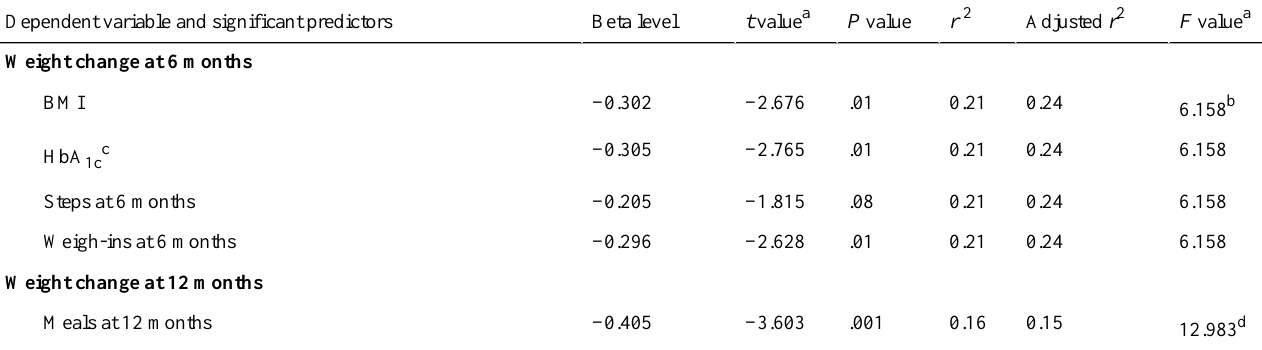
Table 4. Multiple linear regression models for in-app actions as predictors of body weight change adjusting for age and